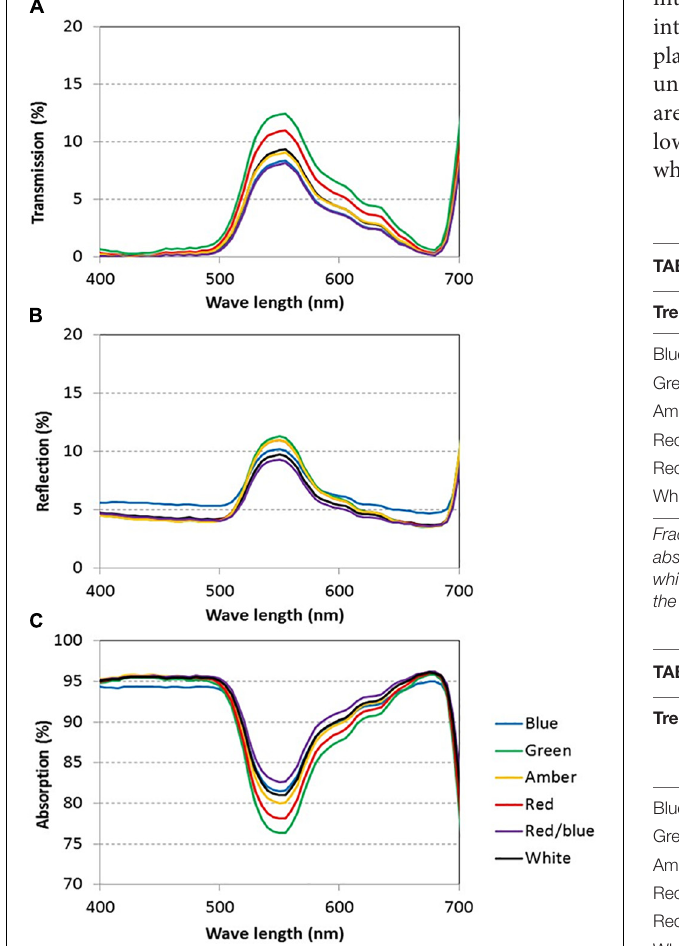
FIGURE 4 | Light transmission (A) , reflection (B) and absorption (C) of tomato leaves grown under blue, green, amber, red, white, and red/blue light during 21 days ( n = 2, average of 4 leaves).